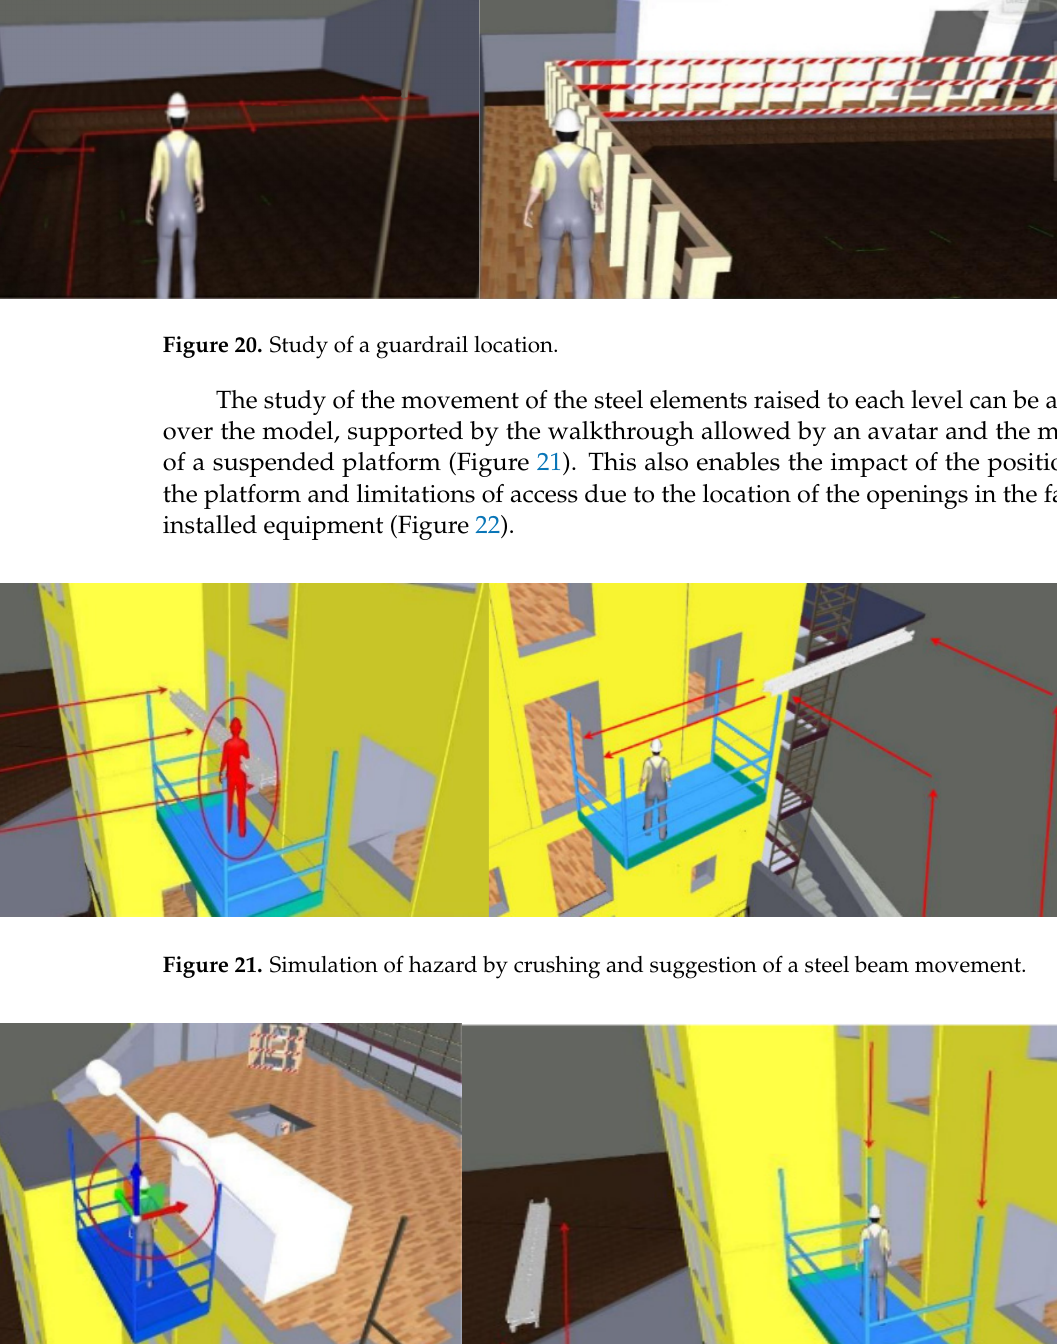
Figure 19. Limit access to the site with a door.